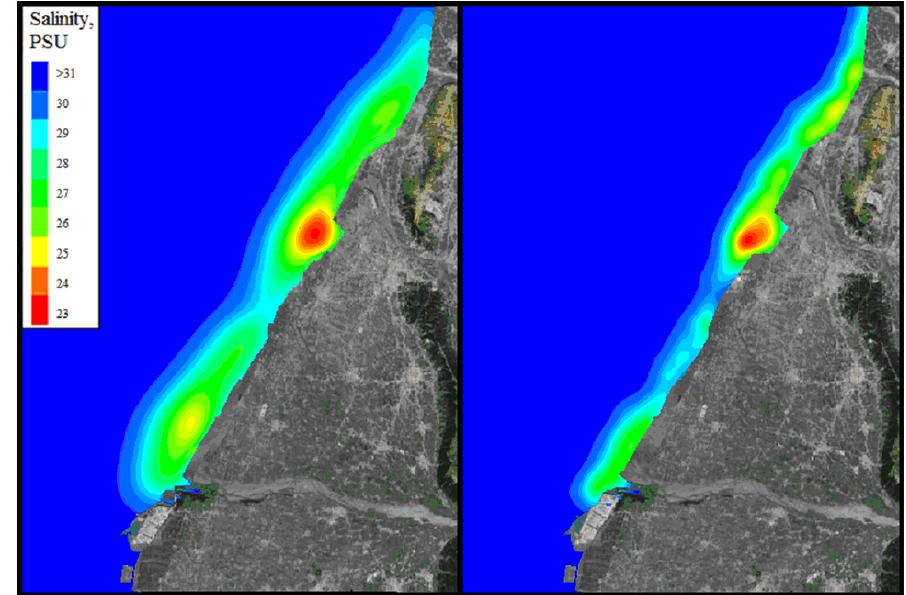
Figure 14. Modelled surface salinity distributions at the study area without WAD (left) and with WAD (right) under “no wind” conditions averaged for the period from 01:00 of 26 June 2013, through 01:00 of 28 June 2013.